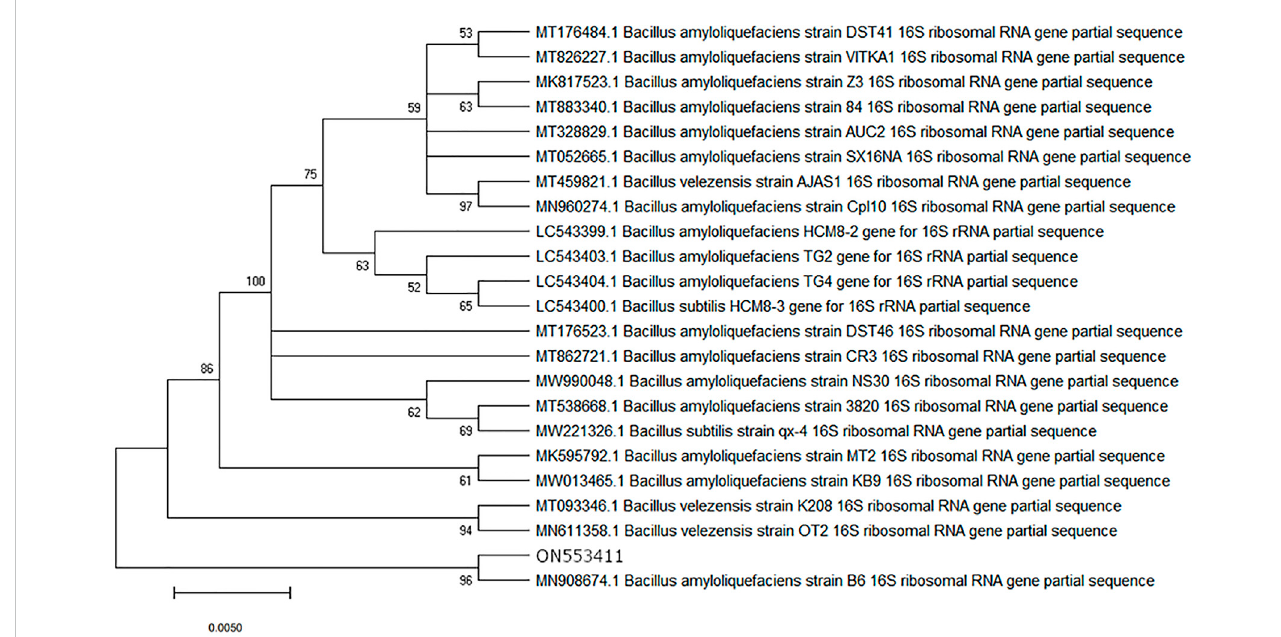
FIGURE 14 Phylogenetic analysis of ON553411 sequence based on 16SrRNA gene sequences of Bacillus strains. Neighbor joining method was used with 100bootstrapreplicationsandgeneticdistanceswerecomputedbyKimura ’ stwo-parametermodel.Onlybootstrappercentagesabove50%areshown.Bars, .005 substitutions per nucleotide